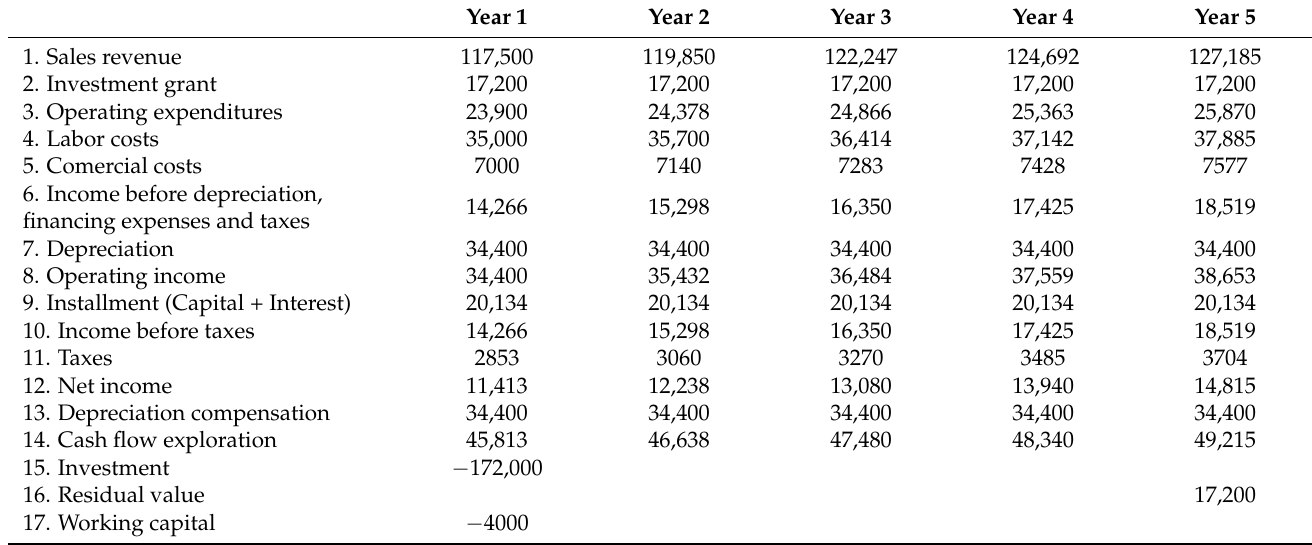
Table 7. Financial cash flow statement